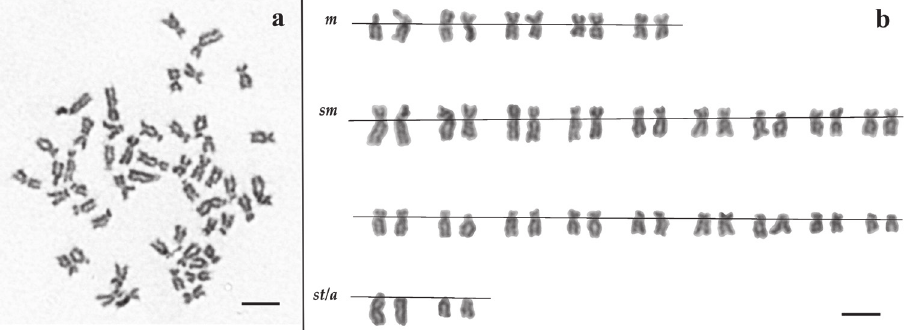
Figure 1. a Giemsa stained metaphase and b corresponding karyotype of a S. aradensis male from Ode- louca River (Arade drainage). Scale bar =